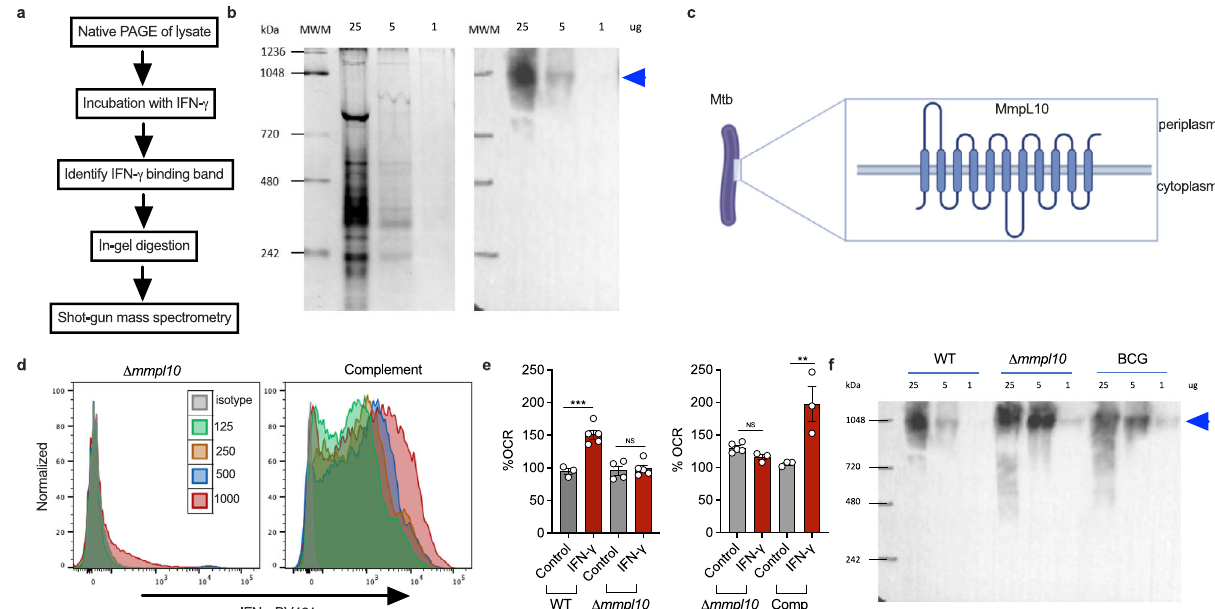
Fig. 3 MmpL10 is the binding partner of IFN- γ . A proteomics approach to identify proteins in Mtb lysate that bind IFN- γ ( a ). Proteins from native page of Mtb lysate ( b , left panel) were transferred to PVDF membrane. Subsequent staining of the membrane yielded an immunoreactive band to IFN- γ ( c , right panel). Subsequent analysis using mass spectrometry revealed the band to contain peptides corresponding to MmpL10 ( c ). Binding of IFN- γ to Δ mmpl10 was abolished, while it was restored in the mmpl10 -complemented strain ( d ). Similarly, the effect on OCR in response to IFN- γ was abolished in Δ mmpl10 and restored in mmpl10 -complemented strain ( e ). Immunoreactive bands were also observed in lysates of Δ mmpl10 and BCG ( f ). Data are shown as